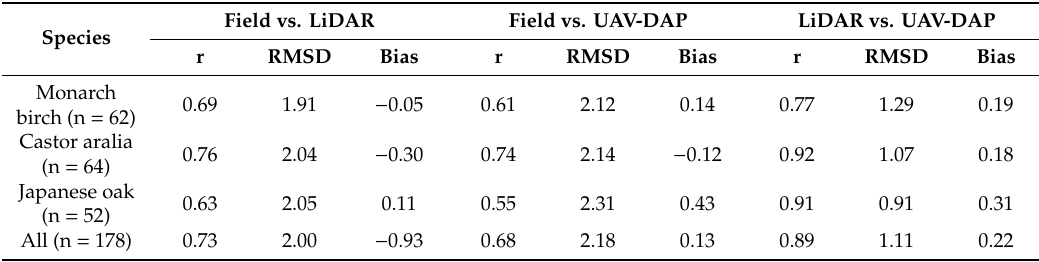
Table 4. Correlation of tree height derived from field, LiDAR and UAV-DAP data for three high-value timber